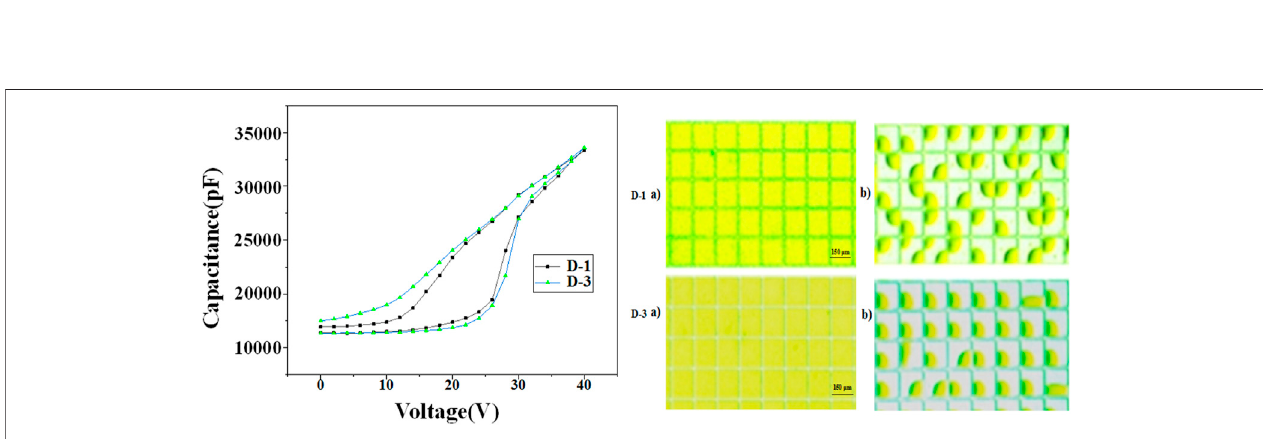
FIGURE 6 | Photoelectric response properties of dyes